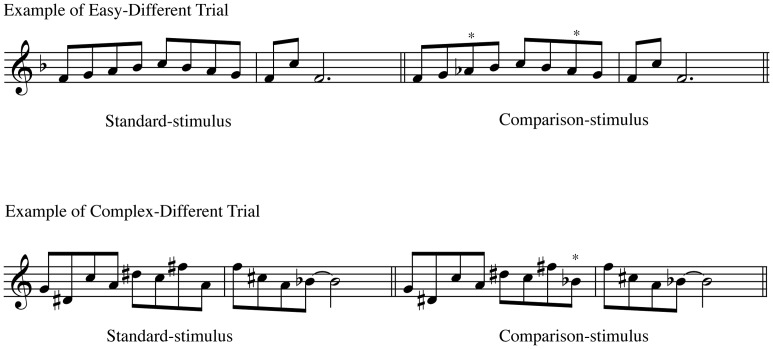
Example of melody trials.An easy trial consists of a tonal melody (upper part) as opposed to a complex trial, which is atonal (lower part). *Represents the alteration in the comparison-stimuli.